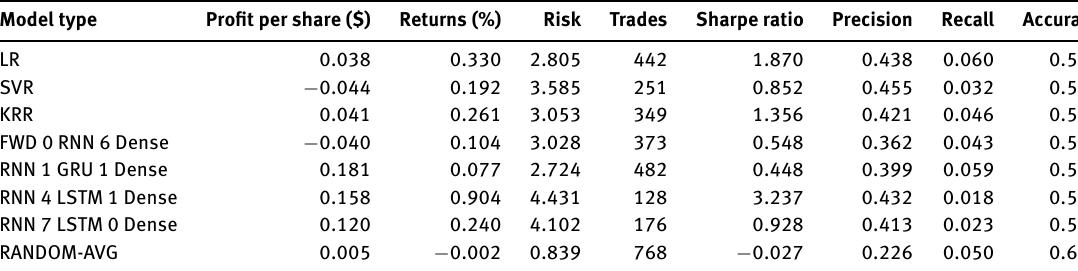
Table 9: 60-Min Regression Model Metrics on Validation Set.